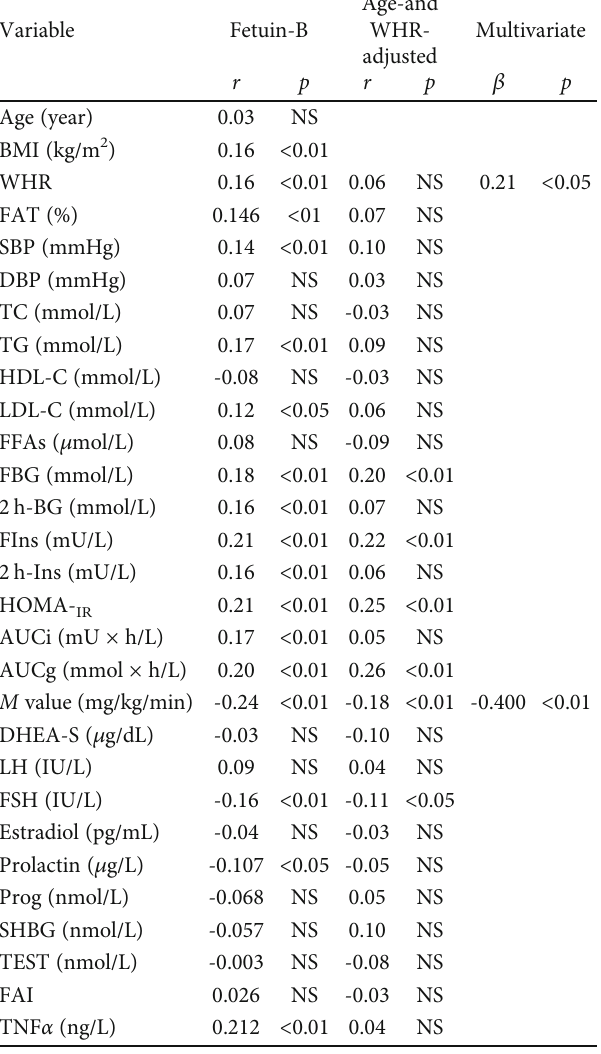
Table 2: The results of linear regression analysis of variables associated with circulating Fetuin-B levels in the study